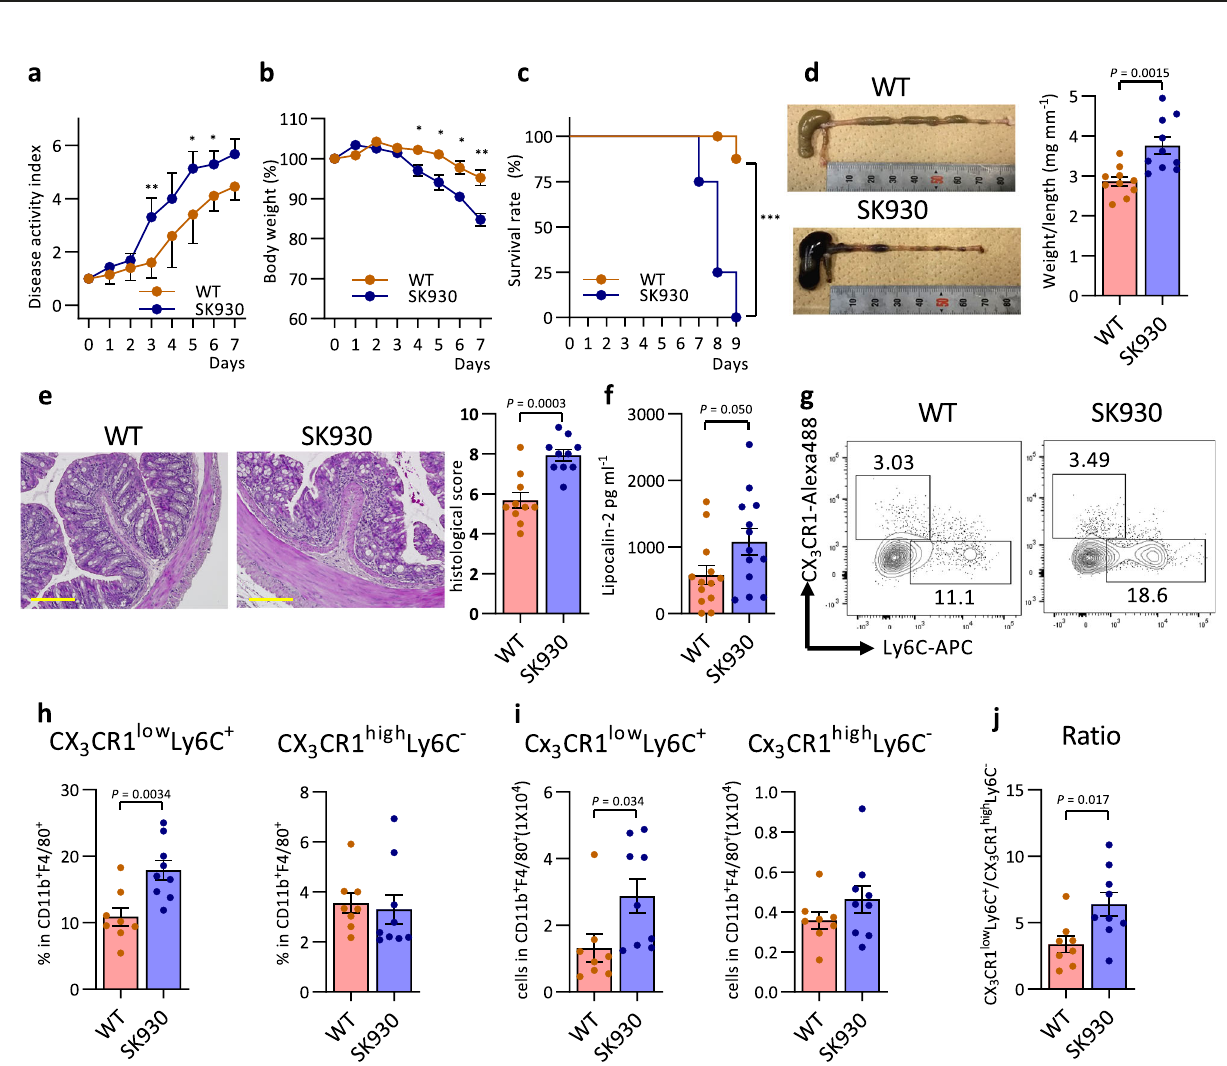
Fig. 5 Bacterial putrescine ameliorates DSS-induced colitis. 2% DSS in the drinking water to the F1 gnotobiotic mice colonised WT or SK930 strain to induce experimental colitis for six days, then regular drinking water thereafter. a – c : Red and blue indicate WT-strain-associated and SK930-strain- associated mice. a DAI score. b Body weight changes were measured daily and calculated as the percentage change from day 0. c Survival rate in mice after DSS administration. The survival curve was calculated using the Kaplan-Meier method and statistical signi fi cance was calculated using the log rank test (WT: n = 10, SK930: n = 8). d – j Mice were analysed on day 5 after starting 2% DSS ( n = 10). d Representative image of the colons and values of weight/length of the colon. e Haematoxylin and eosin-stained images of representative histopathologic changes in the WT and SK930 strain-associated mice. Scale bar: 100 µ m. Mucosal damage was estimated using a histological scoring system. f Faecal lipocalin-2 concentrations in faeces at day 5 after starting 2% DSS. Expression of CX 3 CR1 and Ly6C were analysed in CD45 + CD11b + F4/80 + cells via fl ow cytometry. Representative fl ow cytometry images ( g ), and frequency ( h ) and number ( i ) of CX 3 CR1 low Ly6C + monocyte/macrophages and CX 3 CR1 high Ly6C − macrophages and the ratio of the former to the latter subset ( j ) in the cLP of gnotobiotic mice colonised with WT or SK930 strain (WT: n = 8, SK930: n = 9). All data shown represent the mean ± SEM. Statistical signi fi cance was calculated using the Welch ’ s t -test ( e , h , i ) (two-sided) with Bonferroni adjustments ( a ), Mann – Whitney test with Bonferroni adjustments ( b ), Student ’ s t- test ( d , f , j ) (two-sided) (* P < 0.05, ** P < 0.01, *** P < 0.001).